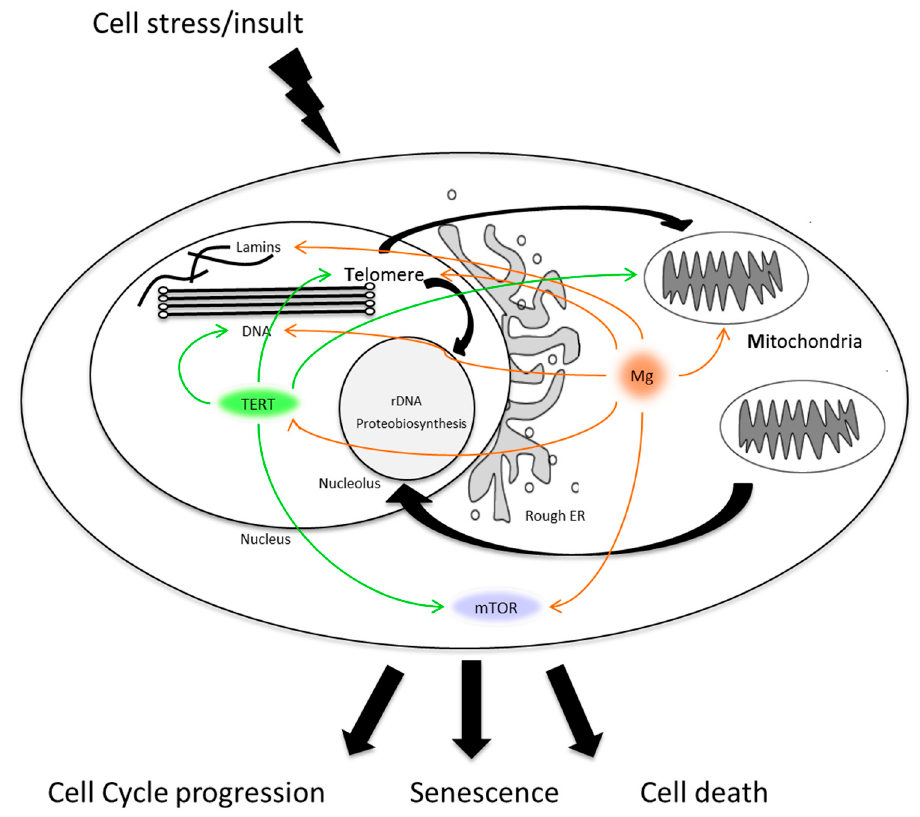
Figure 2. A schematic of the interplay between mitochondria, telomere nucleo-protein complexes and proteo-biosynthesis regulation in response to cellular stress/damage. In response to the stress, the cell will decide how much fuel to burn and energy to expend to repair any damage accrued. If the cell can repair the damage it can progress through the cell cycle. Too much damage and the high risk of onconeogenesis induces cell death. Senescence, strictly in this simplified scenario, sees the cell carry accumulated, sub-lethal damage, as wear and tear, leaving the cell metabolically active, but physiologically non-contributory to the function of the tissue and organ in which it resides. The pervasive and overlapping roles that TERT (green) and magnesium (orange) play in targeting major components of the MRT trinity are highlighted. ER, mTOR/.